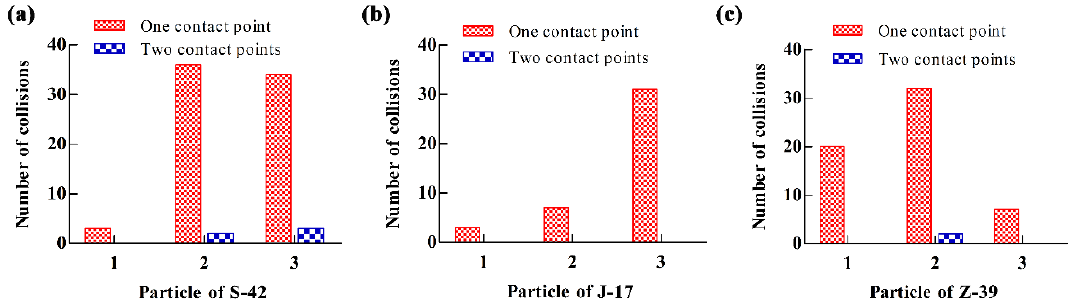
Figure 25. The number of particle–deck collisions for single soybean particles of ( a ) SN42, ( b ) JD17, and ( c ) Z-39.